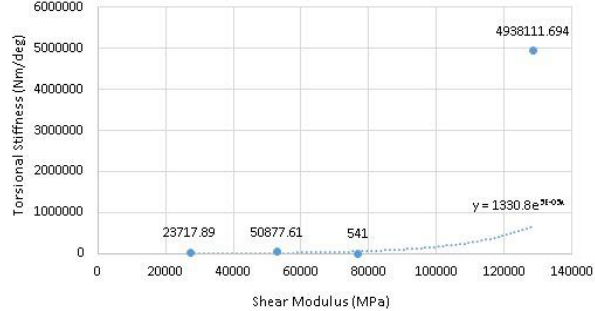
Figure 11: Effect of shear modulus on torsional stiffness